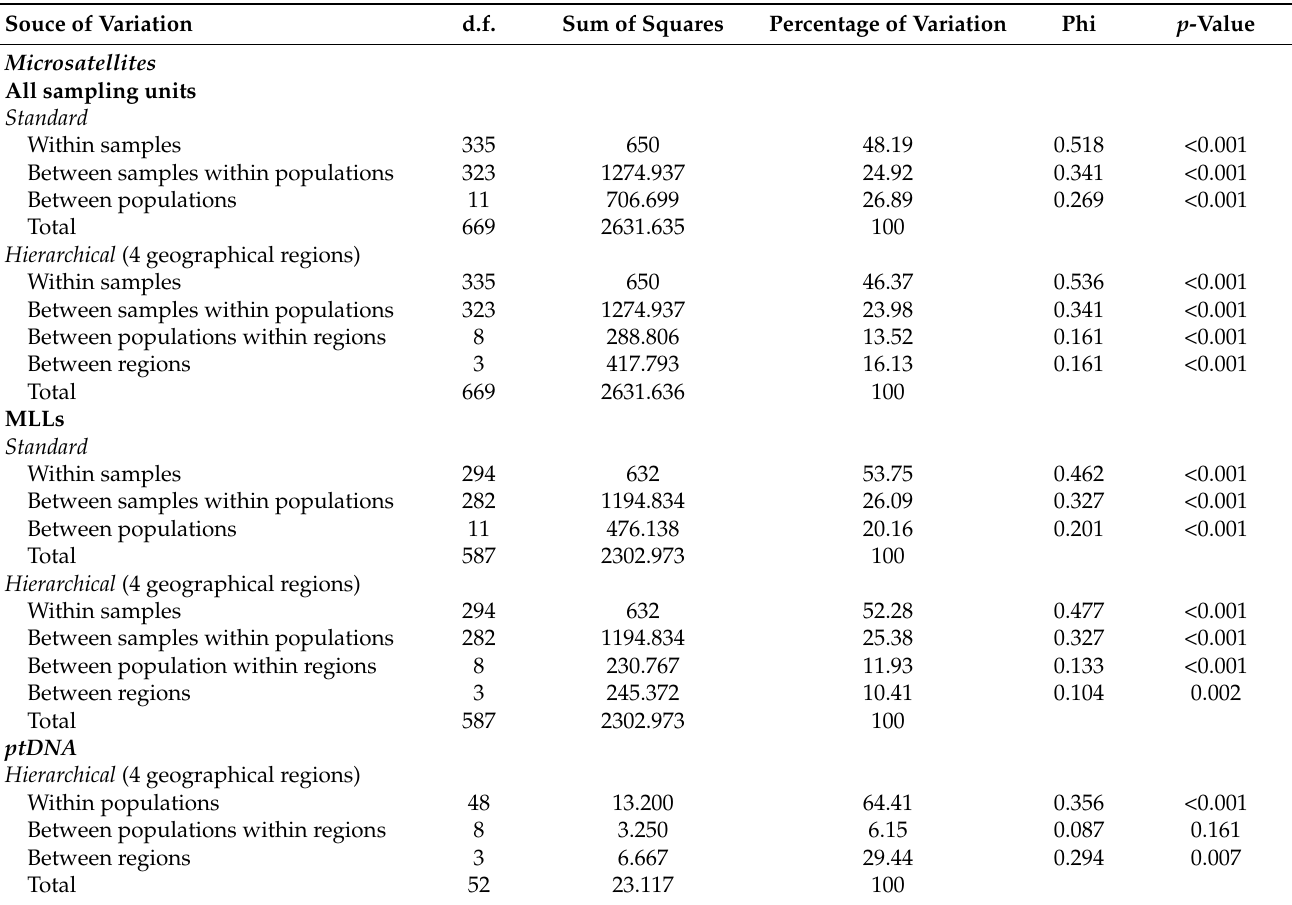
Table 4. Hierarchical analysis of molecular variance